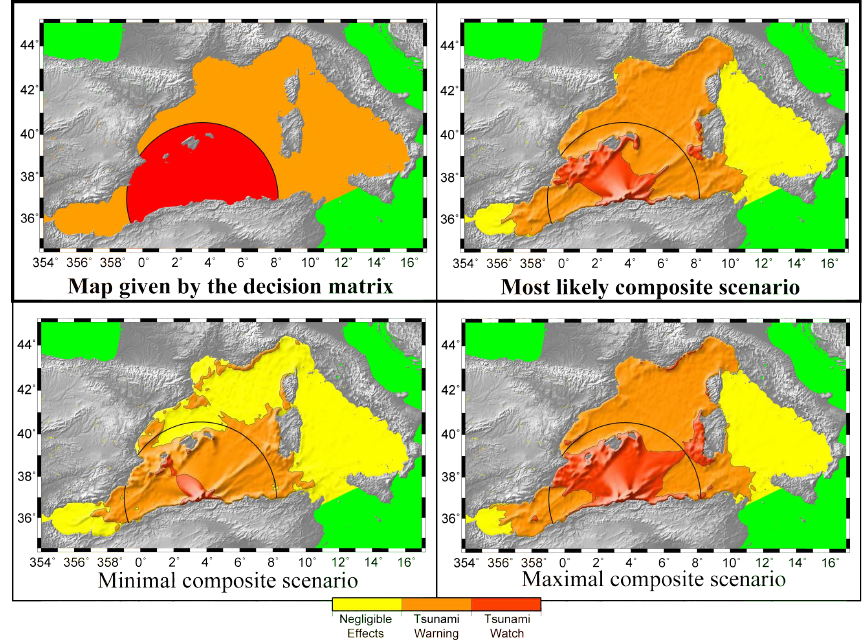
Fig. 7. Final representation produced by the forecasting system to be delivered to the authorities 8h after the detection of a tsunamigenic earthquake. (black circle) 400km radius warning area around the epicenter defined by the decision matrix; (green zones) area not included in the western Mediterranean basin.